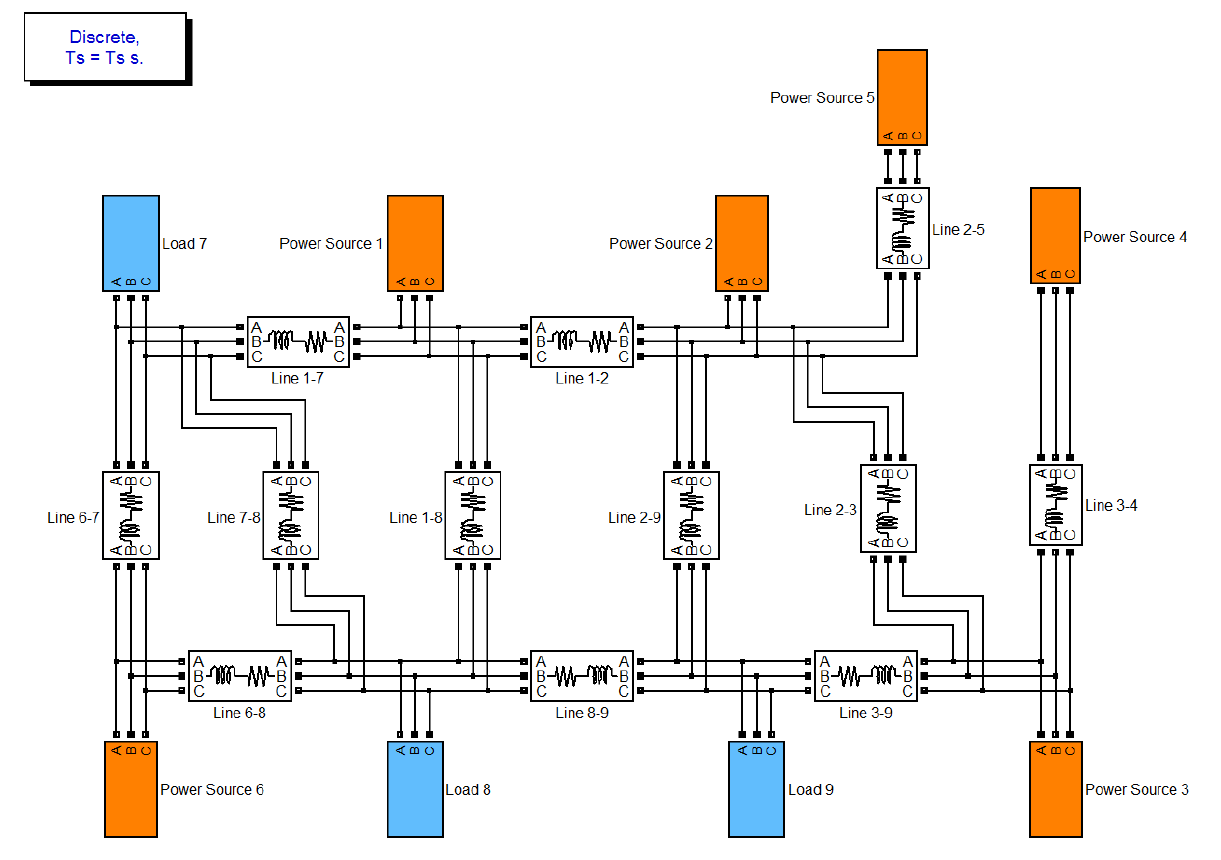
Figure 5. Grid model with six power sources and nine buses.